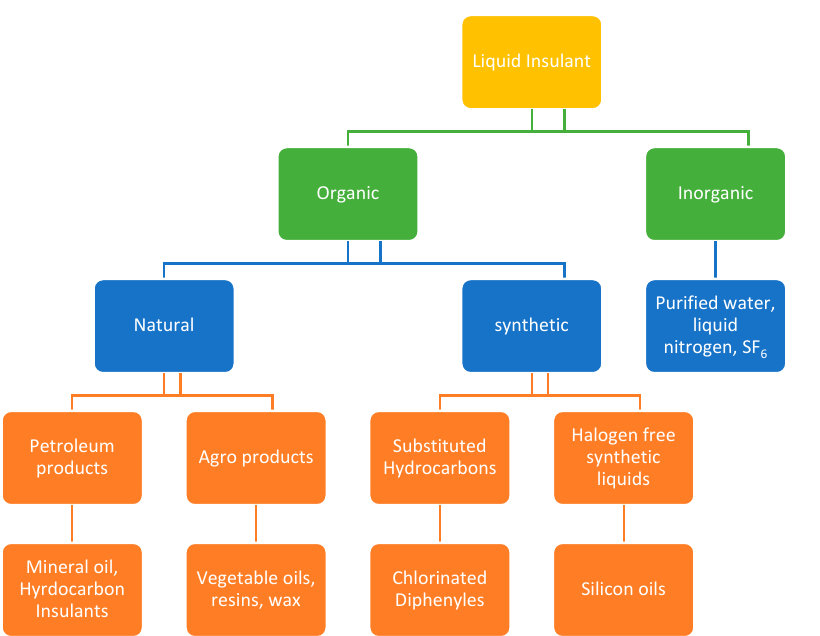
Figure 1. Flowchart showing classification of liquid insulants.